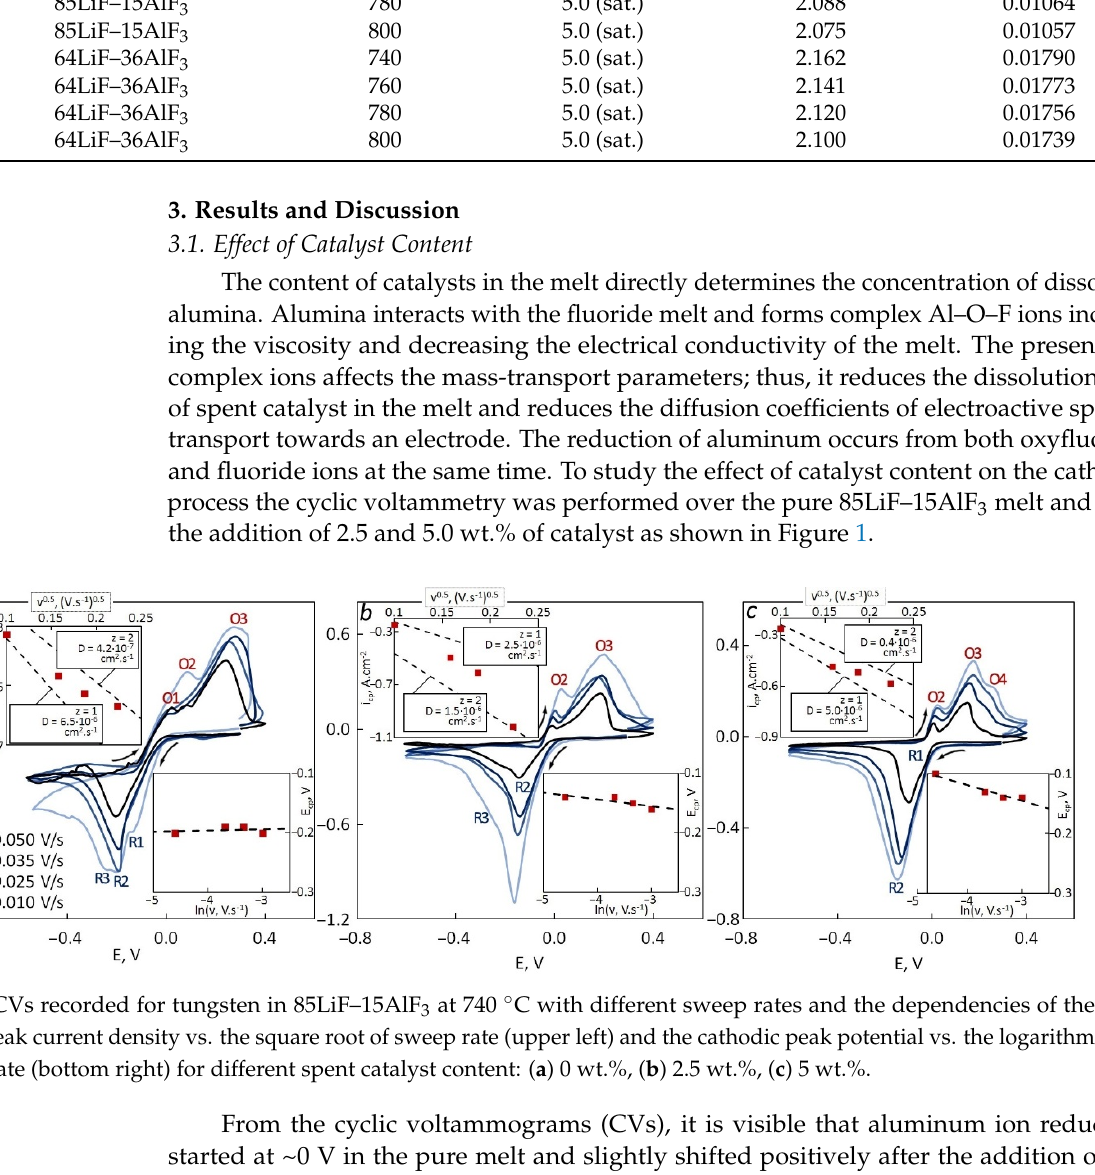
Table 1. Composition and properties of studied systems ( θ is the temperature, SC is the spent catalyst content, ⍴ is the density, C Alz+ is the concentration of Al ions).